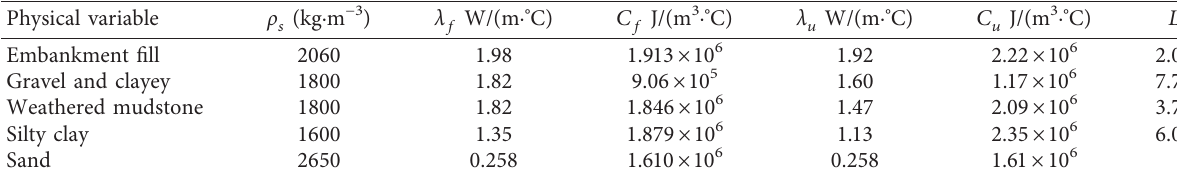
Table 1: Thermal parameters of soil layers.